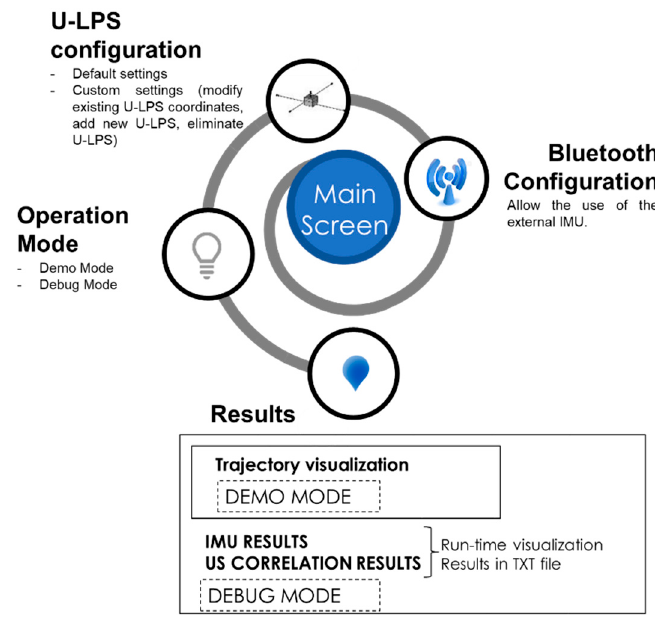
Figure 13. LOCATE-US user interface diagram.